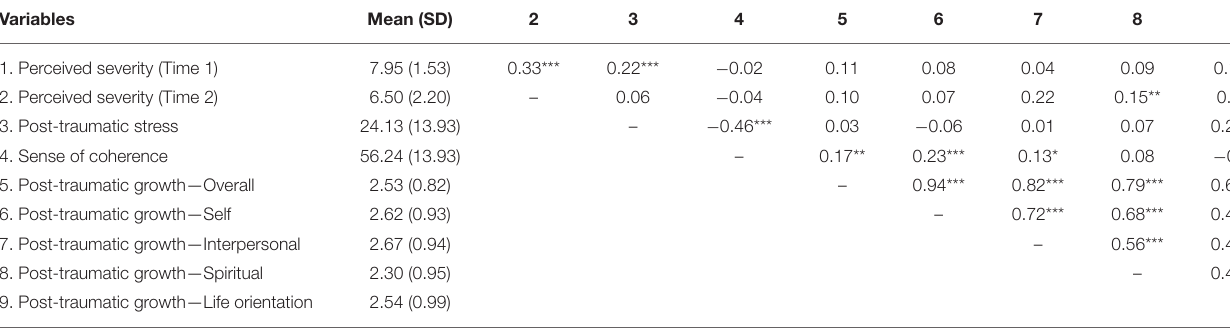
TABLE 2 | Descriptive statistics and intercorrelations among key variables ( N = 327). Variables